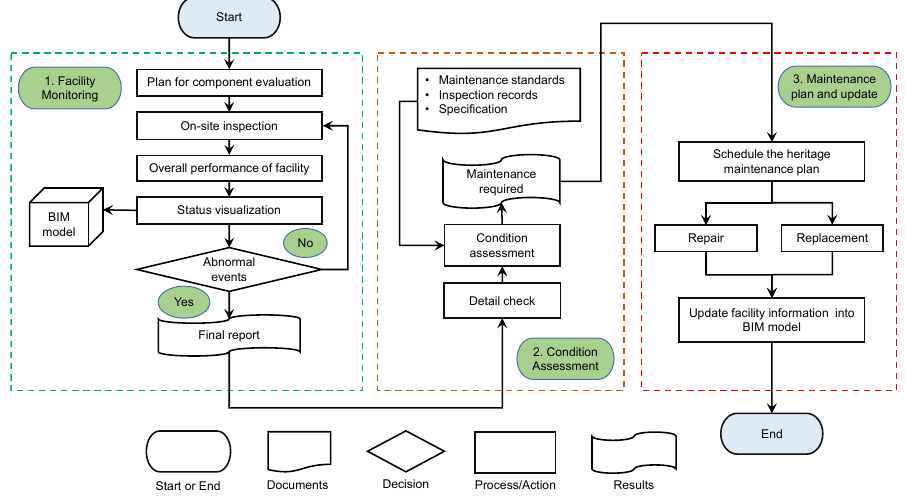
Figure 8. Process of the maintenance tasks supported by the proposed framework.